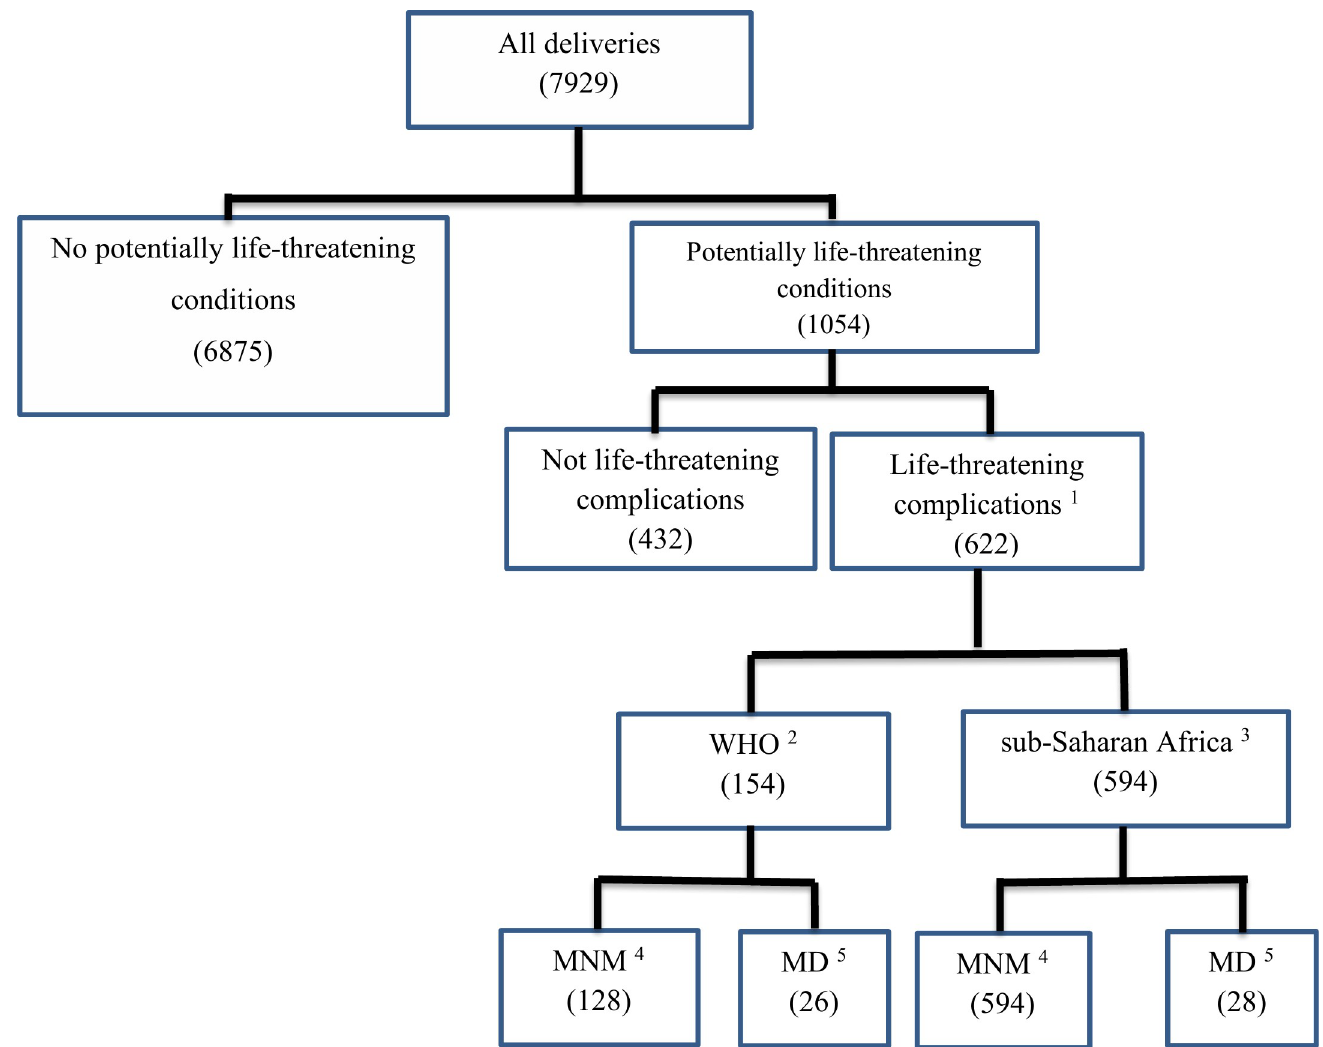
Fig 1. Study flow chart of severe maternal outcomes in eastern Ethiopia. 1 According to the sub-Saharan or WHO criteria 2 World Health Organization MNM criteria 3 sub-Saharan Africa MNM criteria 4 Maternal Near Miss 5 Maternal Deaths.